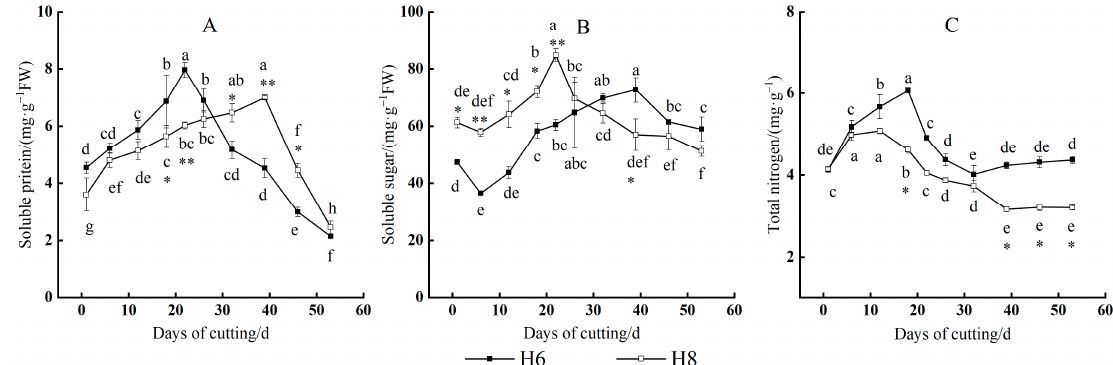
Figure 8. Changes in nutrient content in the cutting rooting of H6 and H8 in E. ulmoides . ( A ) Changes in soluble protein content. ( B ) Changes in soluble sugar content. ( C ) Changes in total nitrogen content. The data are shown as the means ± SEs ( n = 3). Means with the same letter are not significantly different in the same group. * indicates significant difference between the H6 group and the H8 group at the same time. * and ** indicate means at the level of 0.05 and 0.01, respectively.